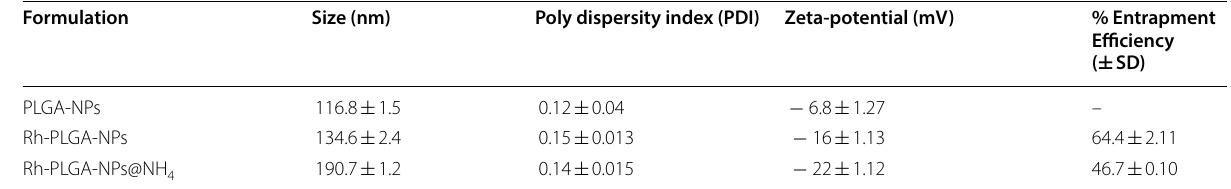
Table 1 Particle size, poly dispersity index, zeta potential and % EE of different Lip Formulation